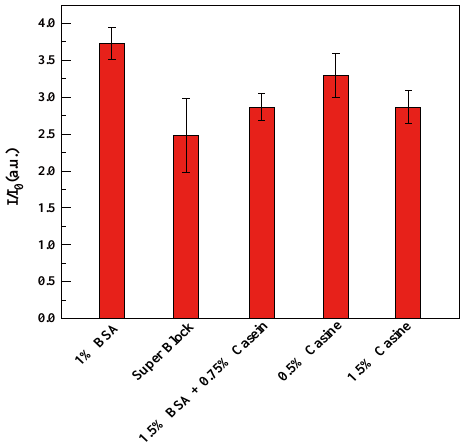
Figure 4. Effect of blocking solutions on the ELISA performed in a microwell array on MCP. The signal to noise ratio (S/N) was calculated from the fluorescence intensity of 100 ng/mL h-IgA solution (S) divided by the blank signal (N).